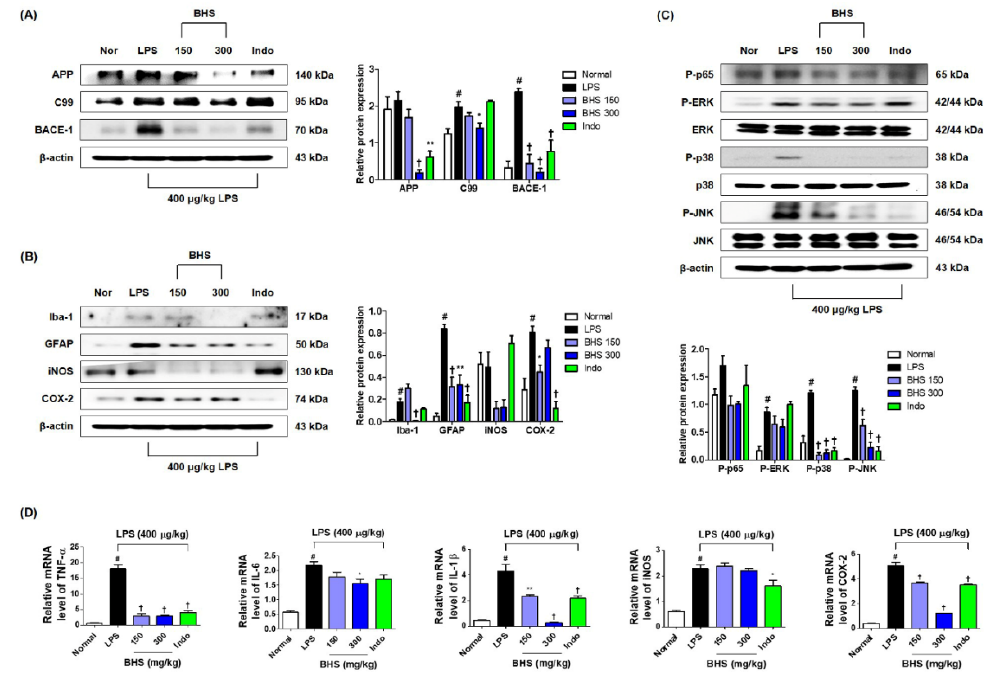
Figure 6. Effects of BHS on LPS-induced amyloidogenesis, neuroinflammation, NF- κ B/MAPK activation, and mRNA expression of inflammatory mediators in the mouse brain. Protein expression levels of ( A ) APP, C99, and BACE-1 and ( B ) Iba-1, GFAP, iNOS, and COX-2 were detected by Western blotting. ( C ) Activation of NF- κ B and MAPK pathways. ( D ) mRNA expression of inflammatory